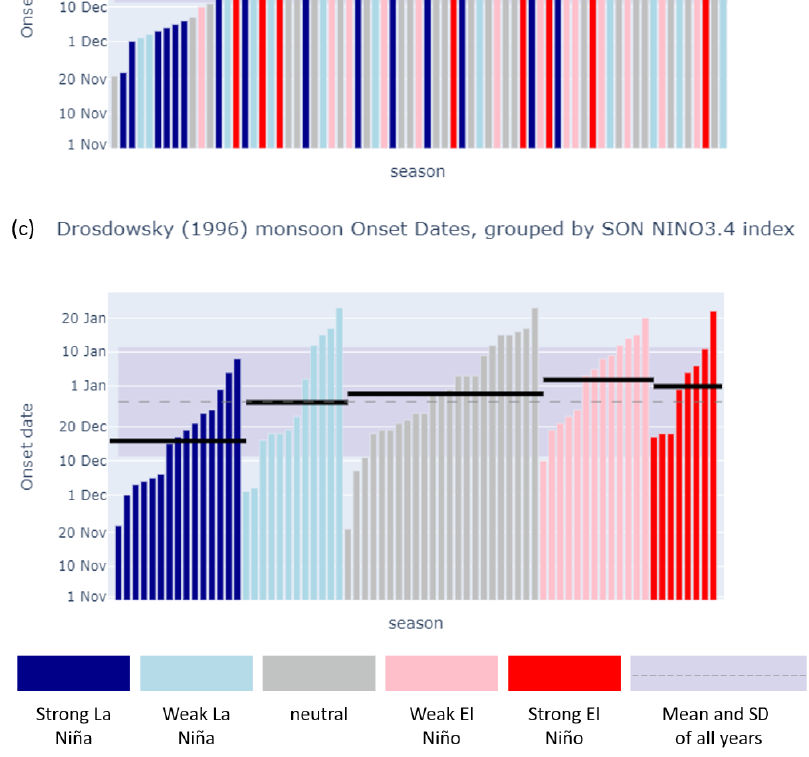
Weather Clim. Dynam., 2, 489–506,